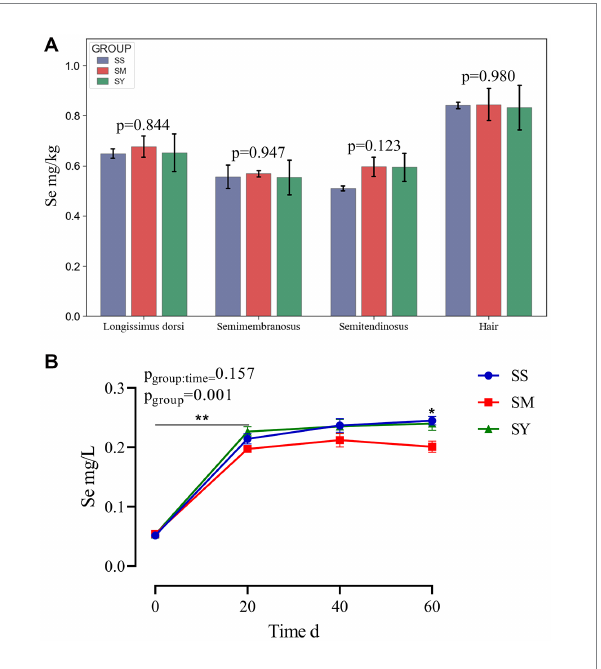
FIGURE 2 Se concentrations in muscle, hair and plasma of beef cattle over the 60 d feeding period. (A) The bar graphs (mean with SD; n = 3) showing the Se concentrations in muscle and hair on day 60; (B) The line chart (mean with SD; n=5) showing the plasma Se concentration on day 0, 20, 40 and 60. * p < 0.05, ** p < 0.01. SS, diet supplemented 0.1 mg Se/kg DM from sodium selenite; SM, diet supplemented 0.1 mg Se/kg DM from; SY, diet supplemented 0.1 mg Se/kg DM